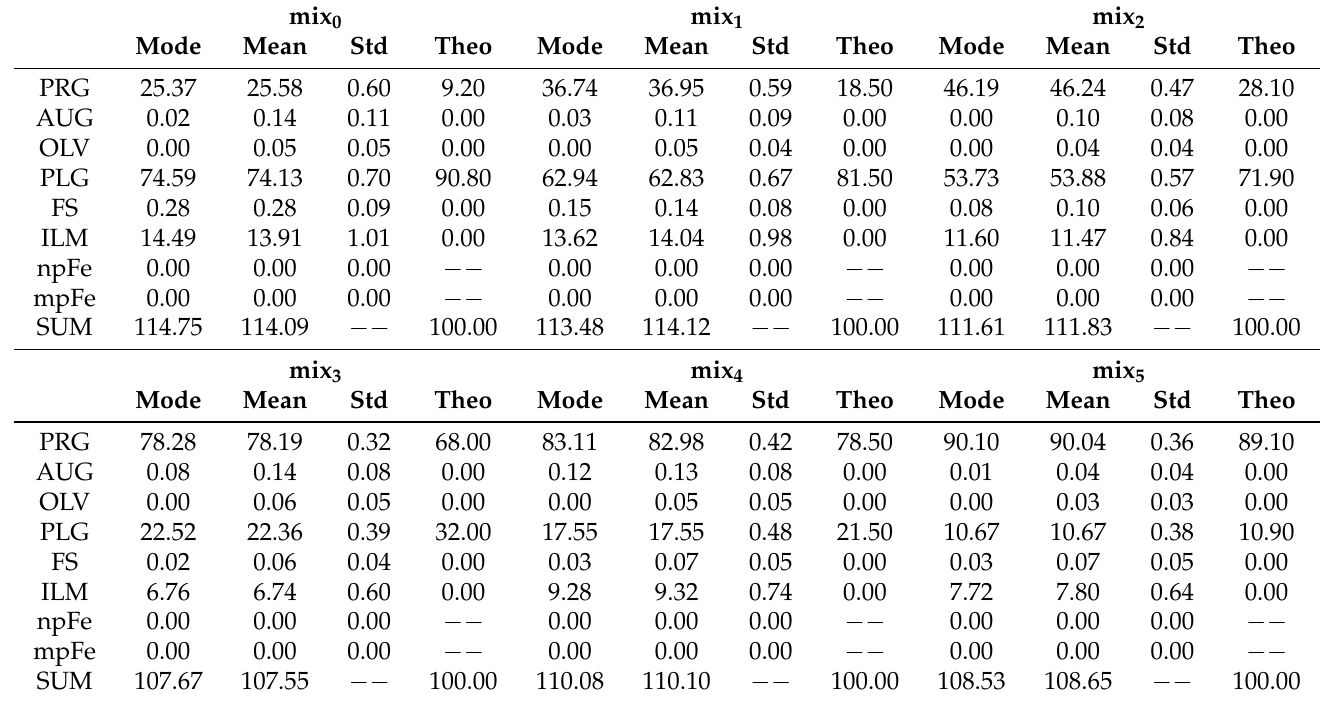
Table A7. Detailed results for the unmixing of fresh laboratory spectra from Rommel et al. [13]. The results were obtained without the use of an elemental